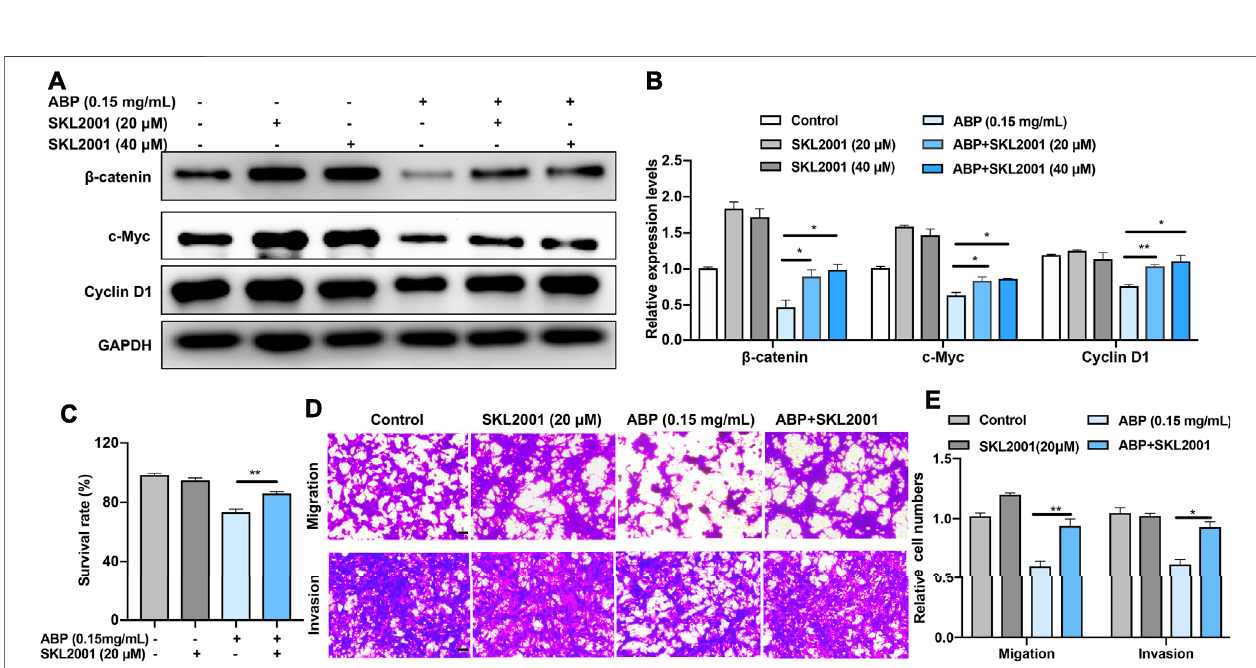
FIGURE 3 | ABP treatment suppresses the growth and metastasis of CRC cells by downregulating β -catenin. (A – B) Western blot examining the effects of SKL 2001( β -cateninactivator)on β -catenin,c-Myc,andCyclinD1levelsinCT26cellstreatedwithABP. (C) CCK-8assayexaminingtherescueeffectsofSKL2001treatment on CT26 cells treated with ABP. (D – E) Transwell assay examining the rescue effects of SKL2001 treatment on CT26 cells treated with ABP. Scale bar (cid:2) 50 μ m. Compared with the ABP group, * p < 0.05, ** p < 0.01.